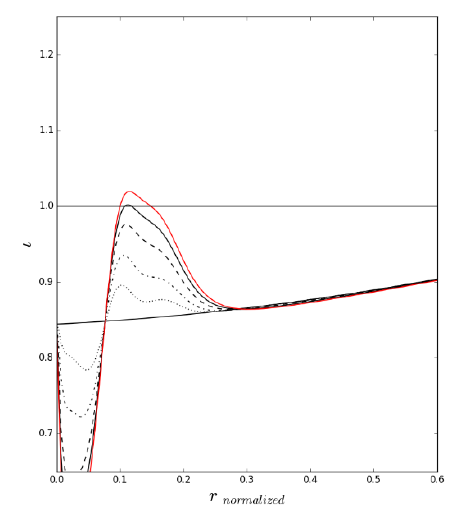
Figure 11: Current changes modify rotational transform, which is plotted for different times as a function of the effective